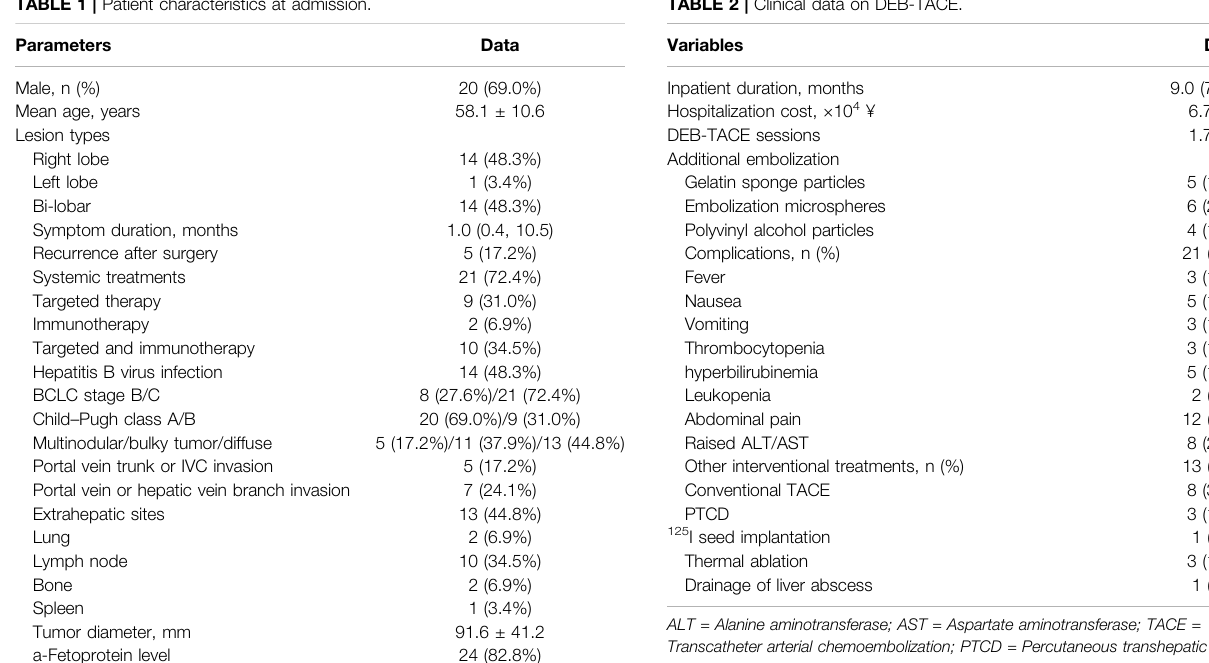
TABLE 1 | Patient characteristics at admission. TABLE 2 | Clinical data on DEB-TACE.